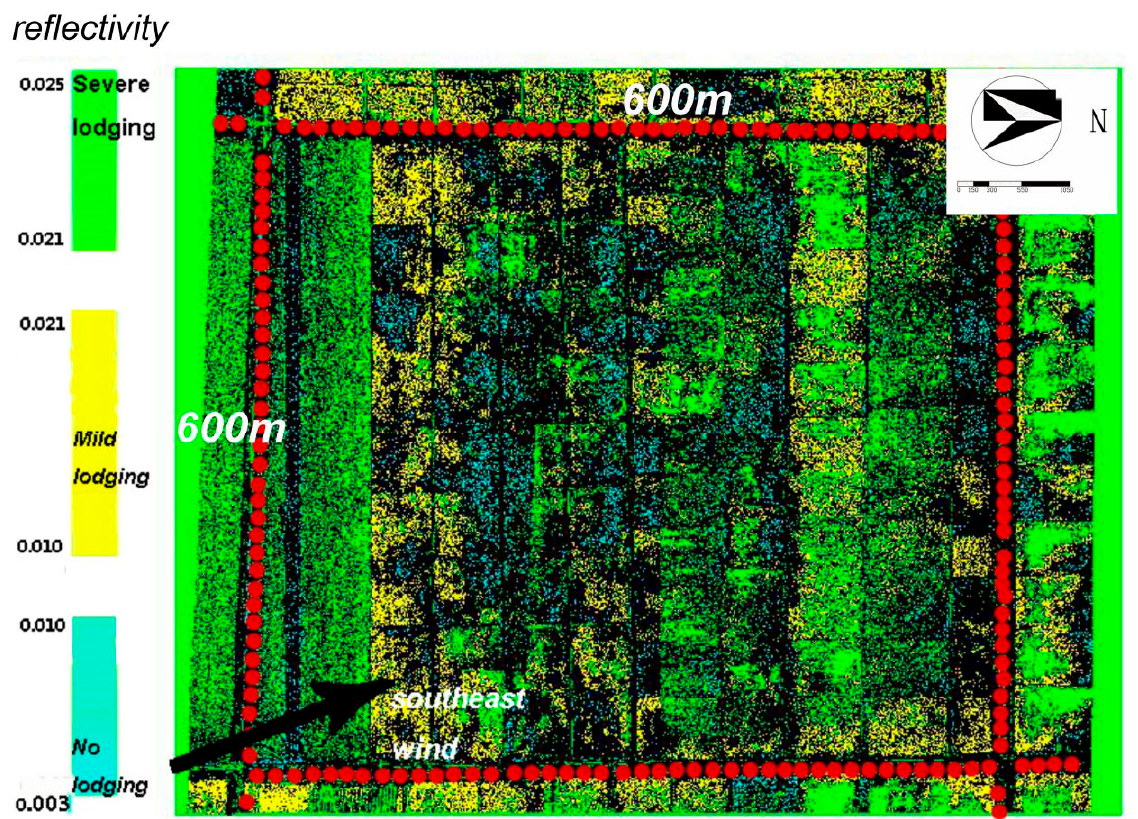
Figure 6. Spatial distribution of rice lodging in a shelterbelt network. Note: Green represents crop severe lodgings, yellow represents mild lodging, and blue represents no lodging. Black is shadows. Red dots indicate trees. The arrow represents the direction of the wind (25° N by W).